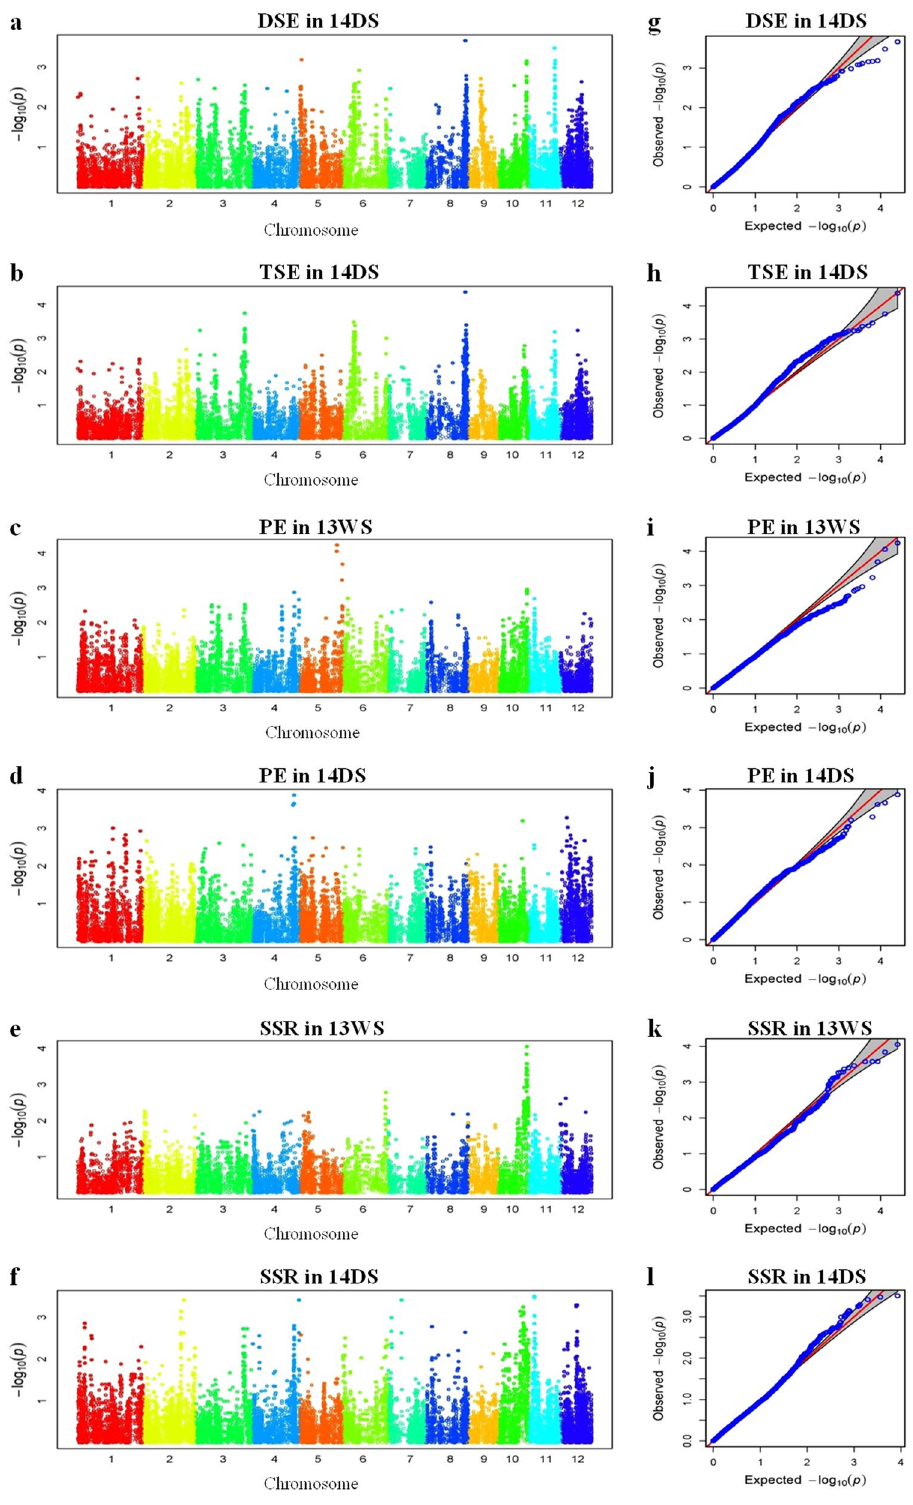
Figure 4. Genome-wide association study of three key traits for outcrossing in 217 cytoplasmic male sterile lines. ( a – f ), Manhattan plots for double stigma exsertion rate (DSE) and total stigma exsertion rate (TSE) in 14DS, and panicle enclosure rate (PE) and seed-setting rate (SSR) in wet season of 2013 (13WS) and dry season of 2014 (14DS). ( g–l ), Quantile-quantile plot. The grey areas are the 95% confidence intervals under the null hypothesis of no association between the SNP and the trait. The red line is the expected line under the null distribution. The blue points are the observed